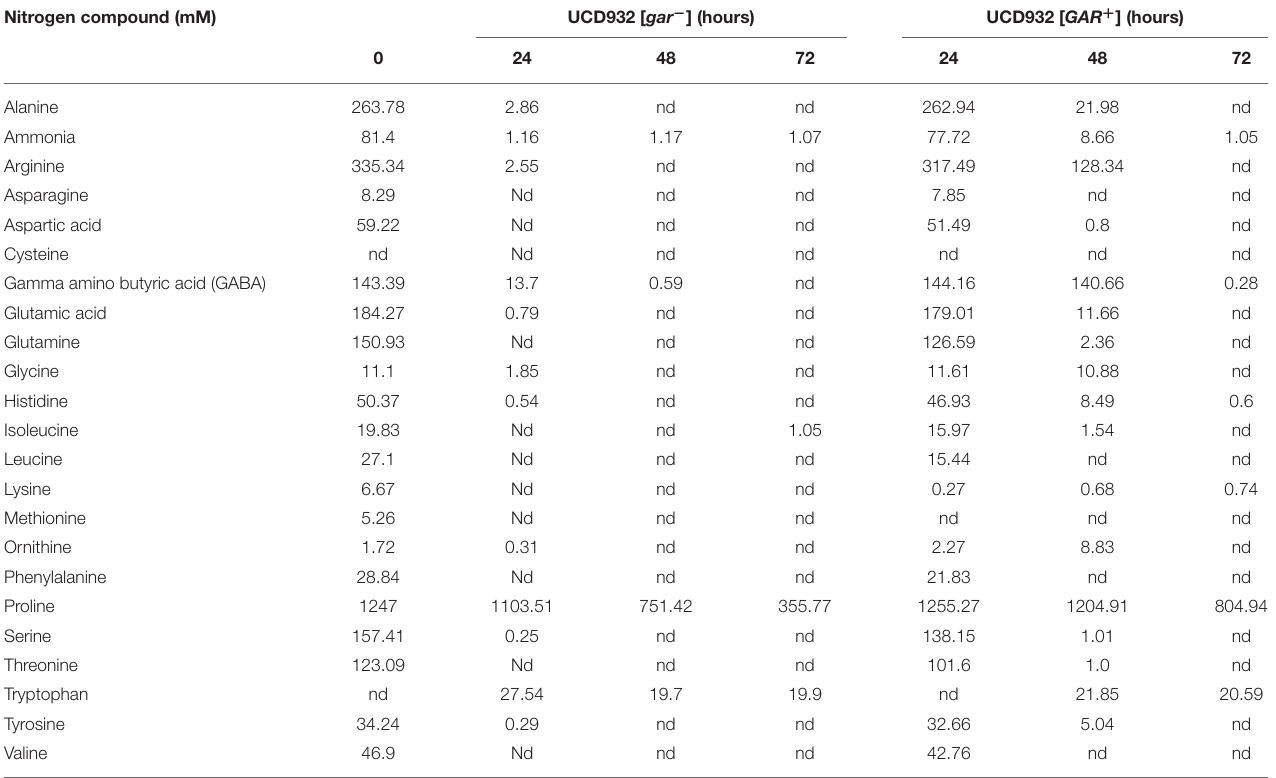
TABLE 3 | Amino acid depletion in [ GAR + ] and [ gar − ] cells of UCD932 during Chardonnay juice